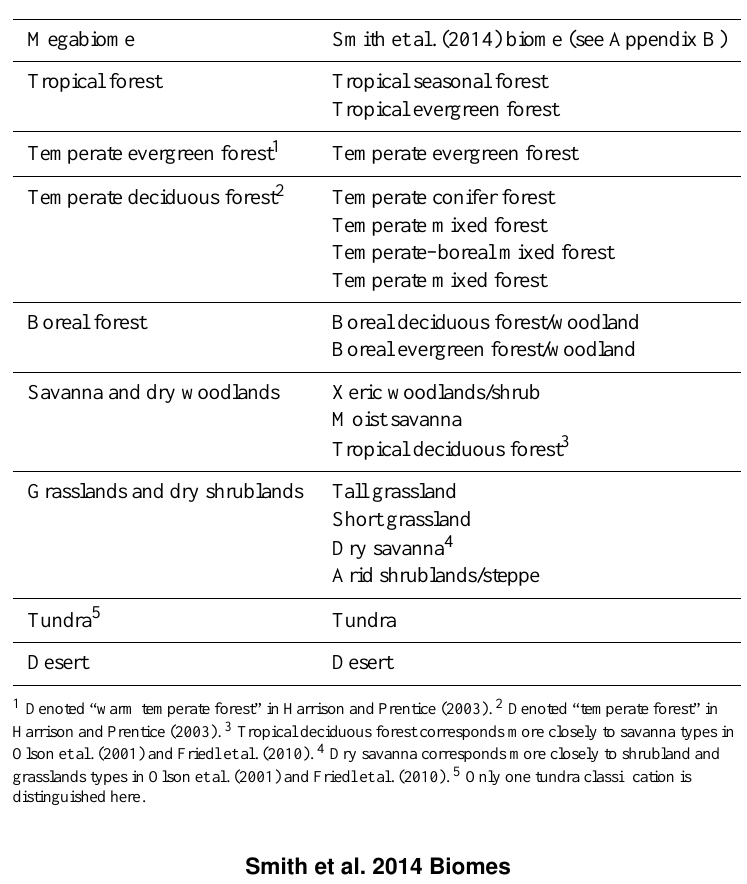
Table C1. Biome aggregation scheme following Harrison and Prentice